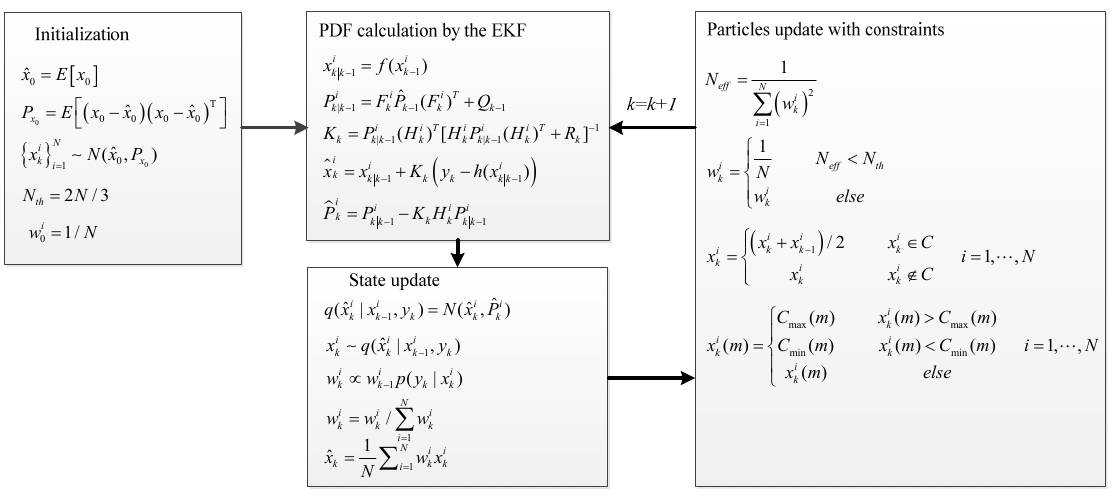
Figure 1. Constrained EKPF algorithm